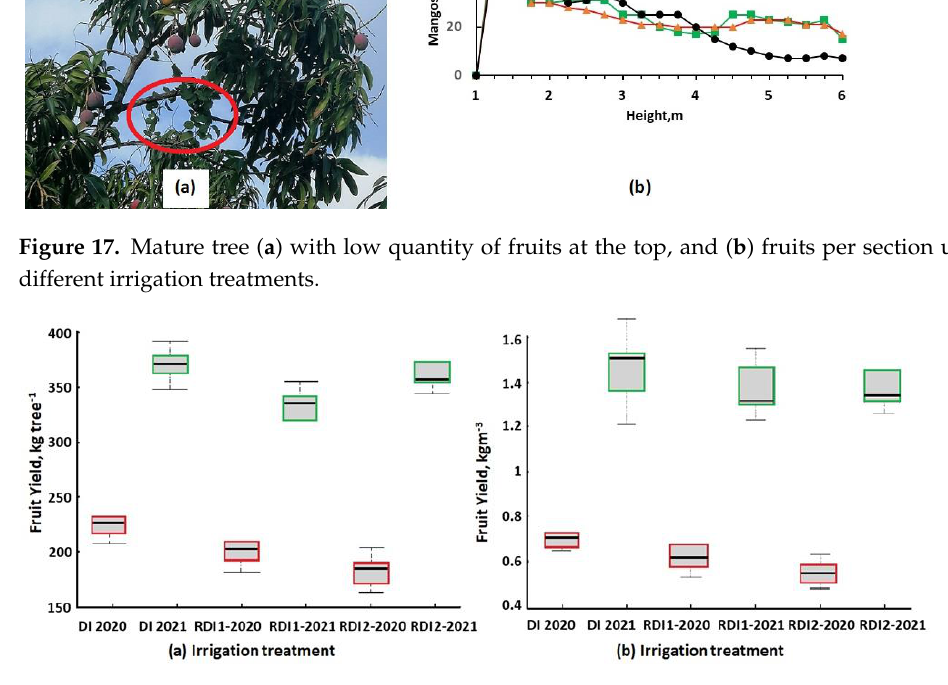
Formatted: Not Highlight